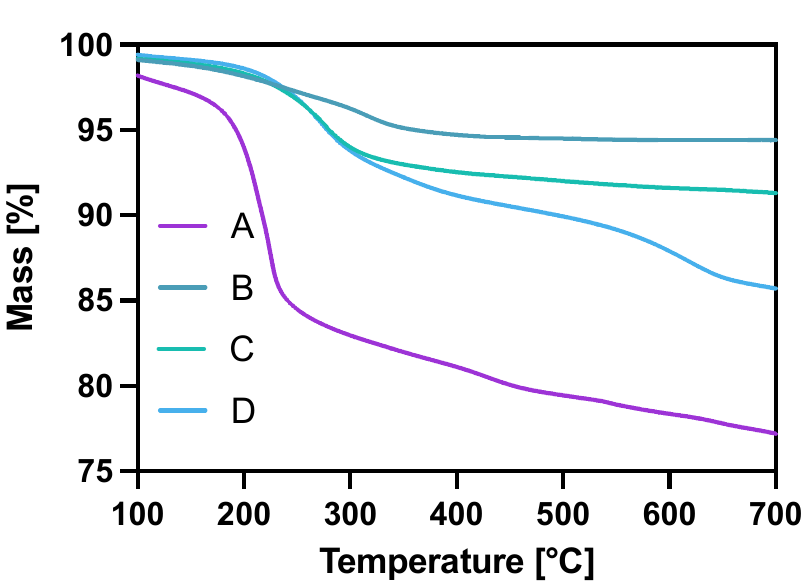
Figure 3. Thermograms of A—NPs-citric, B—NPs-Au, C—NPs-PEG, D—NPs-Tmab.